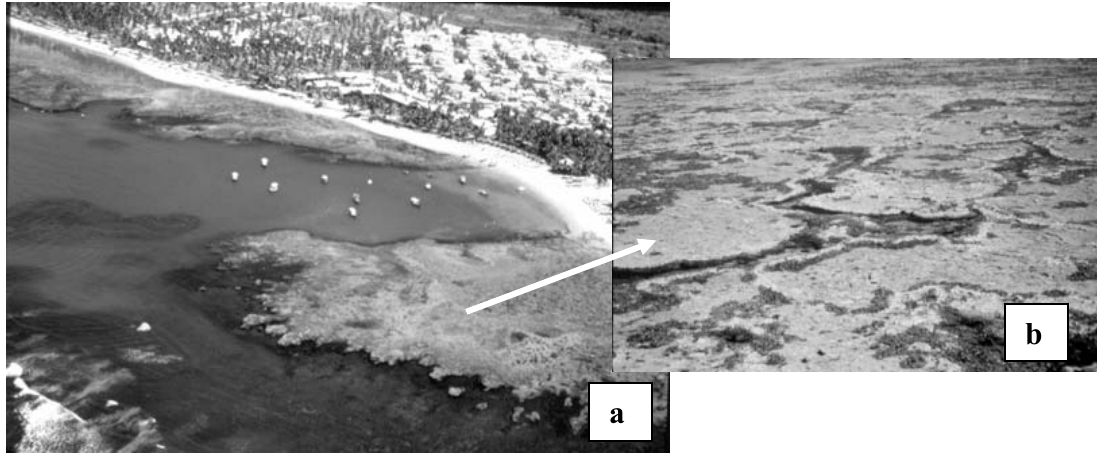
Fig. 4 – a) The emergent top of Forte Beach Reef at the north coast of the State of Bahia. b) Detail illustrating truncated colonies of endemic